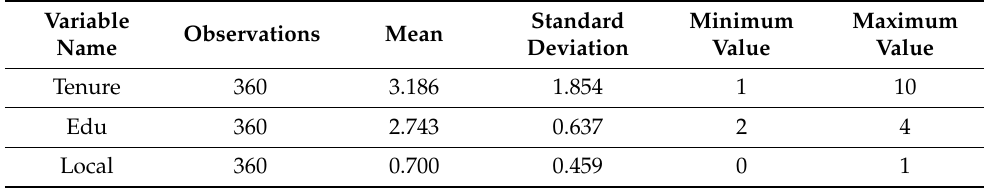
Table 2. Descriptive statistics of main